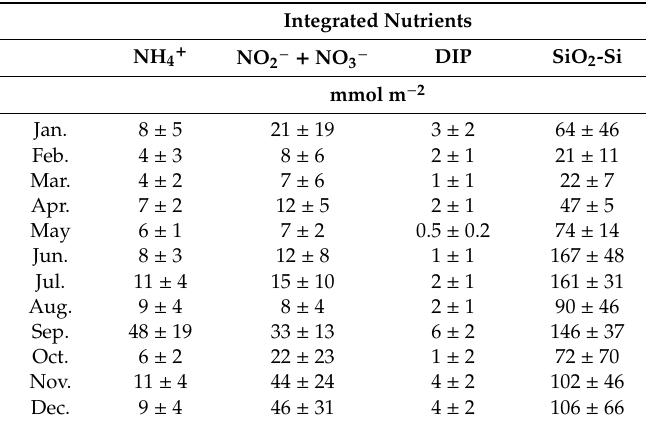
Table 1. Monthly variations in the water column-integrated major nutrient concentrations averaged from seven di ff erent stations in Jaran